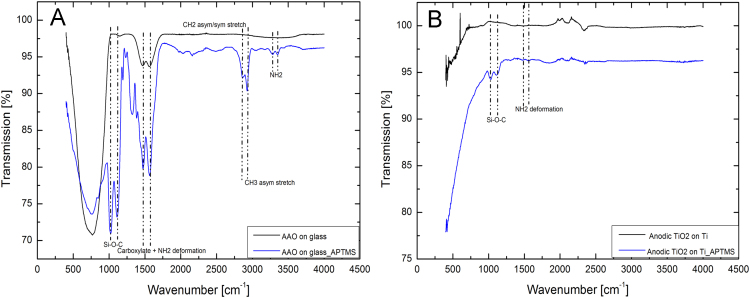
ATR-FTIR spectra of the pristine and aminosilane-functionalized (A) AAO and (B) TiO2-NT.